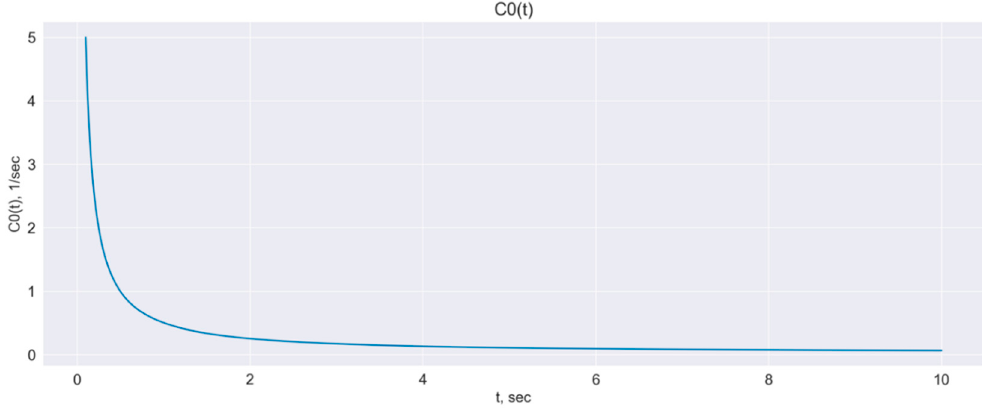
Figure 1. Plot of the C 0 ( t ) function.